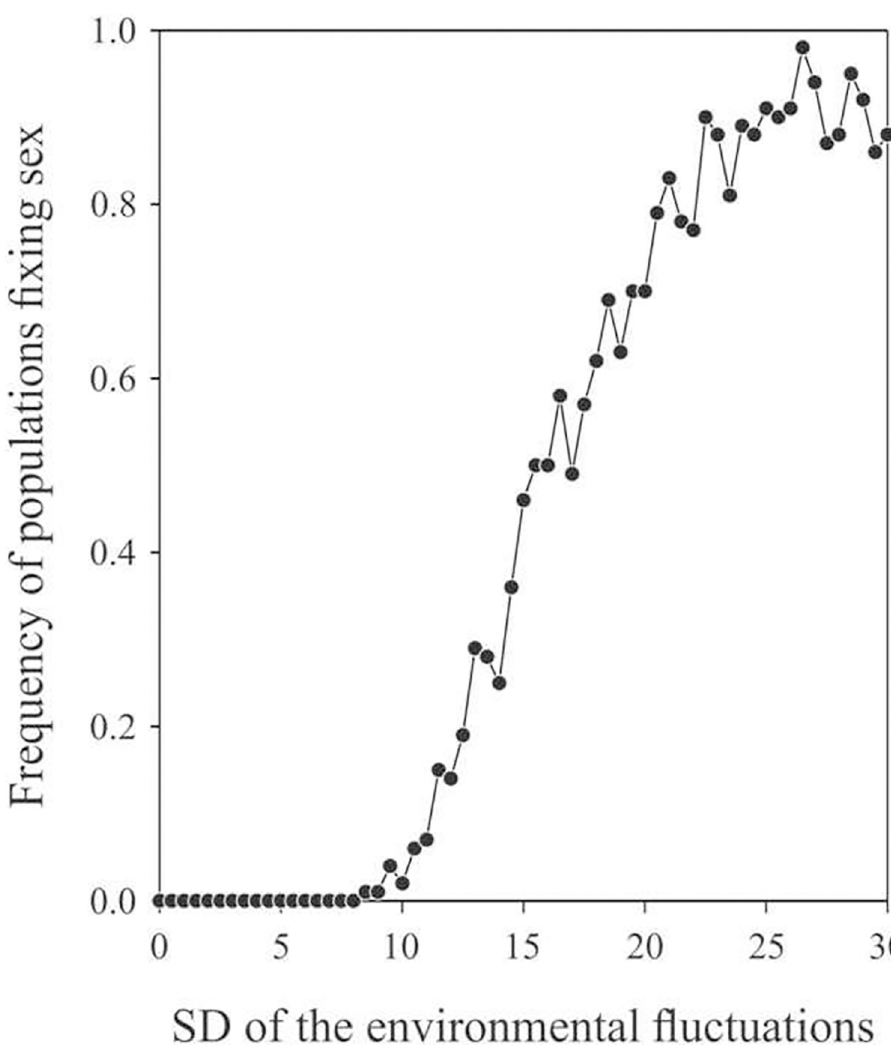
Fig 1. Proportion of populations where sexual reproduction fixed as a function of the variance of random environmental fluctuations. In this example, a SD of 8 resulted in the fixation of sex in more than 5% of the populations, corresponding to the case with no negative frequency-dependent selection resulting from the Red Queen Hypothesis and with no inter-generational autocorrelation in environmental fluctuations. In these simulations, ecological niche width was defined as 2 ω =